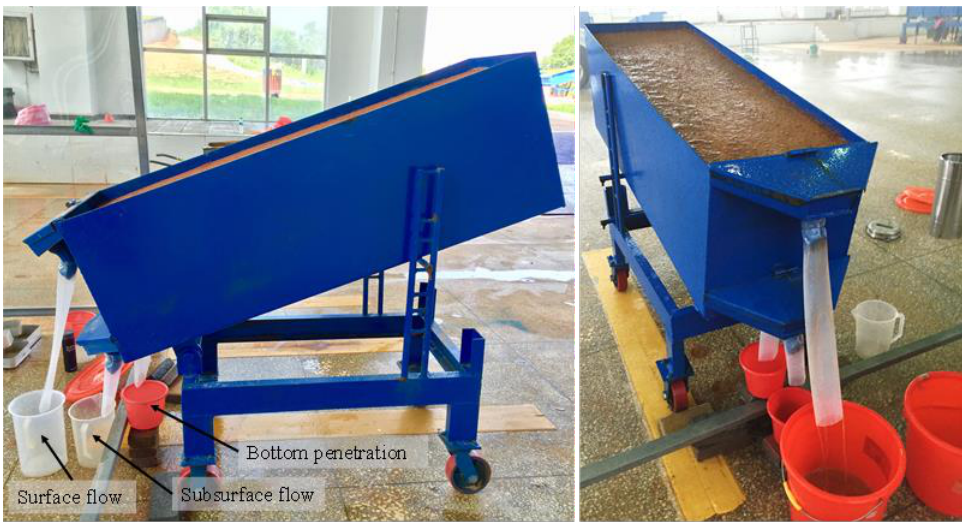
Figure 2. The structure of the experimental soil plot. Table 1. Characteristics of the soil used in the present study.